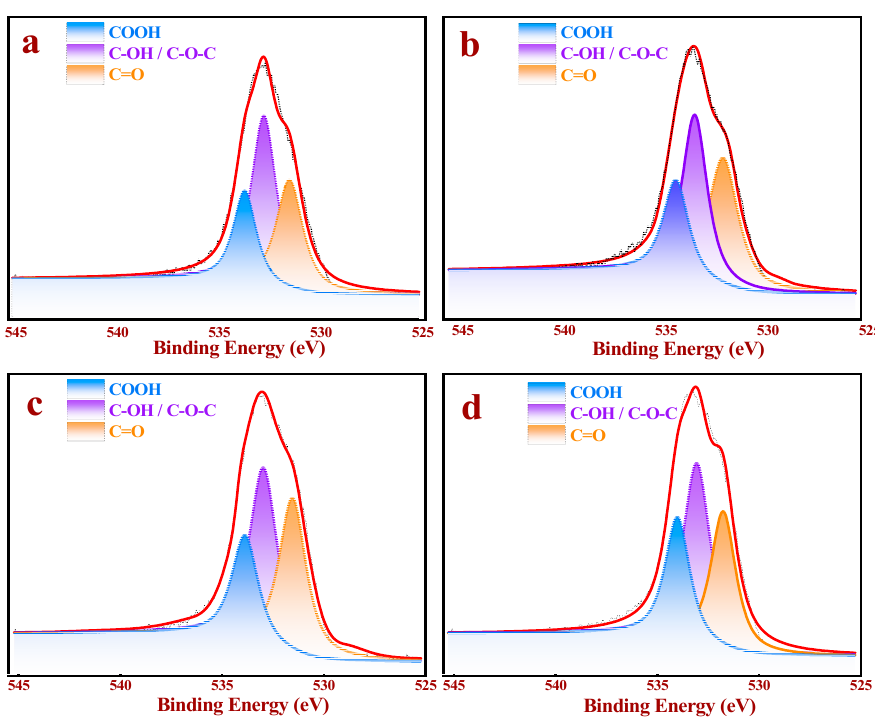
Figure 3. XPS O 1s spectra of the different supports: ( a ) AC, ( b ) AC-10, ( c ) AC-30, and ( d ) AC-60.